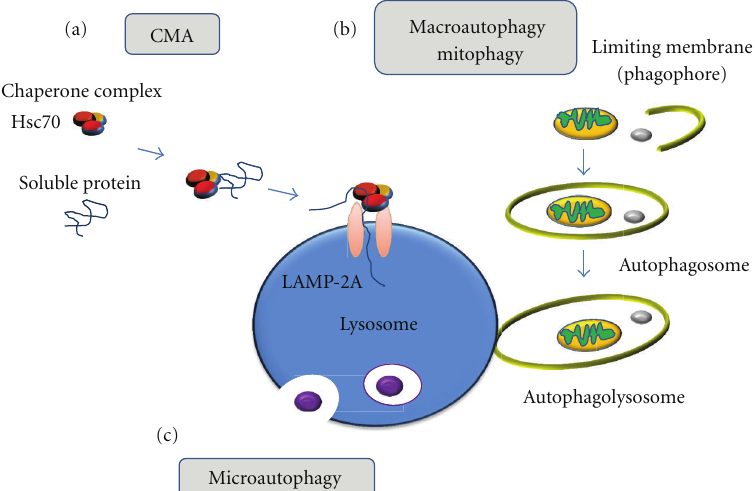
Figure 1: Schematic depiction of the three types of autophagy. (a) Chaperone-mediated autophagy. The cytosolic chaperone protein HSC 70 binds to the substrate protein; the consensus sequence LysPheGluArgGln of the substrate-chaperone complex is recognized by LAMP-2A, a lysosomal membrane receptor. The protein substrate is then unfolded and translocated across the lysosomal membrane to be degraded inside the lysosome. (b) Macroautophagy. Cytosolic material is sequestered by an expanding membrane sac (phagophore) forming a double-mem- brane vesicle, an autophagosome. Fusion of the autophagosome to the lysosome will expose the content of the autophagosome to lysosomal hydrolases. (c) Microautophagy. Small proteins can be engulfed directly by the lysosome without intermediate